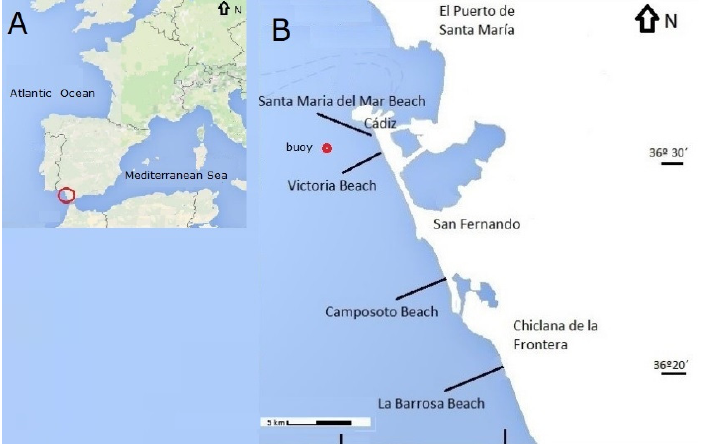
Figure 1. Location of the study area ( A ), the four beaches analysed in the Gulf of Cadiz and the wave buoy ( B ).